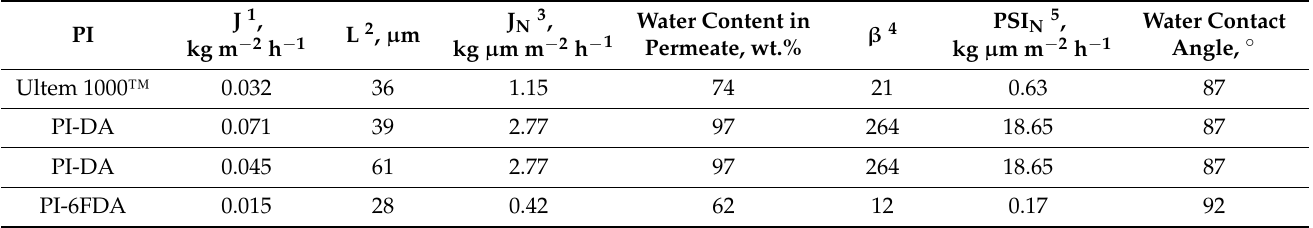
Table 5. Transport properties of PI membranes in pervaporation of isopropyl alcohol/water